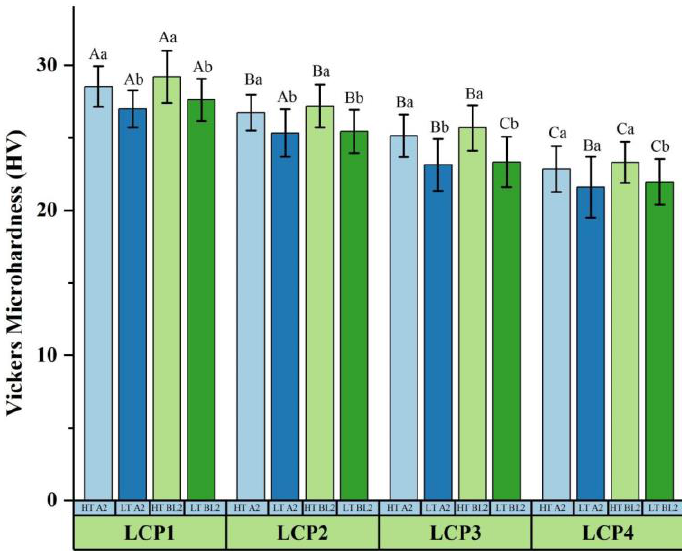
Figure 3. Vickers microhardness observed for the different light-curing protocols and different ceramic optical properties. Different capital letters indicate statistically significant differences between groups for different light-curing protocols; different lowercase letters indicate statistically significant differences between different transparency groups of ceramic specimens; p < 0.05.